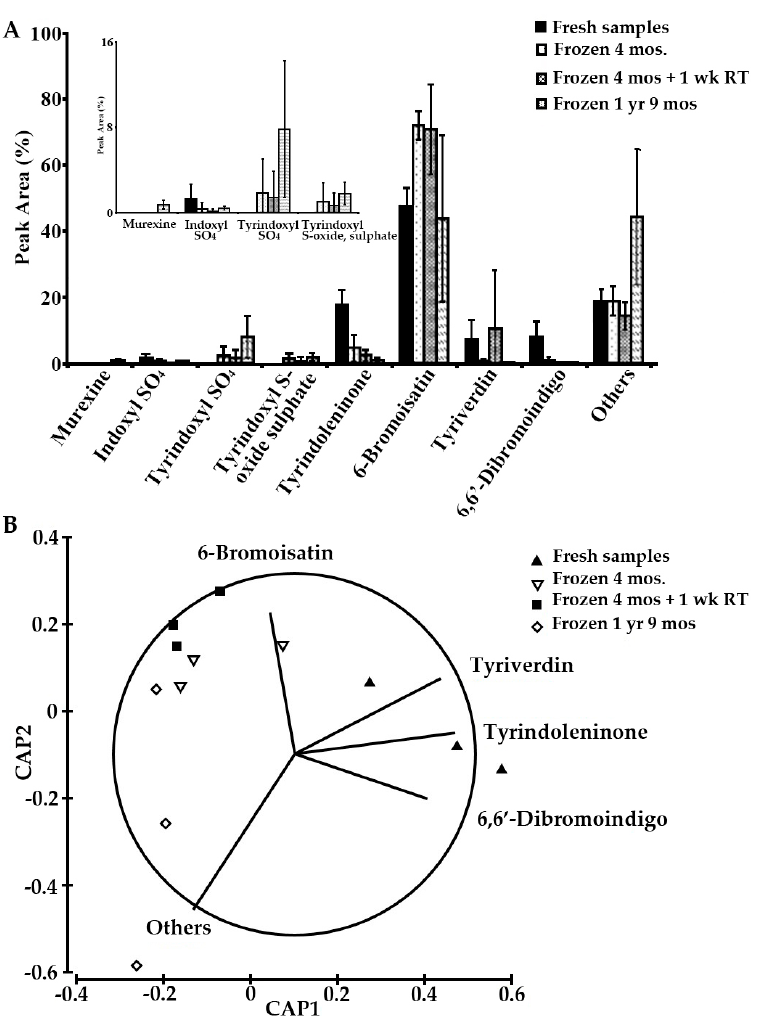
Figure 8. Stability of the bioactive compounds from chloroform extracts of the hypobranchial gland of Dicathais orbita ( n = 3). ( A ) Histogram showing the relative (%) integrated peak areas from the HPLC absorbance at 210 nm of the bioactive compounds of D. orbita analysed at different times. Inset graph shows magnification of the changes in minor compounds; ( B ) Canonical analysis on the principal coordinates with vector overlay based on Spearman correlation > 0.6.